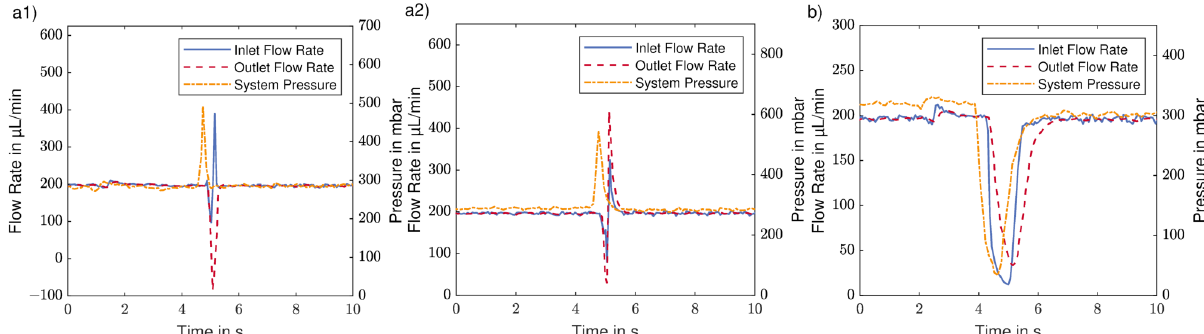
Figure 7. Flow rate profiles at valve in- and outlet and system pressure; ( a1 ) 3D-printed valve with piston pump, not tight case; ( a2 ) 3D-printed valve with piston pump, tight case; ( b ) Äkta column valve with piston pump. Due to different accuracies of time stamps of used flow and pressure sensors, there is a maximum possible offset between shown pressure and flow rate curves of